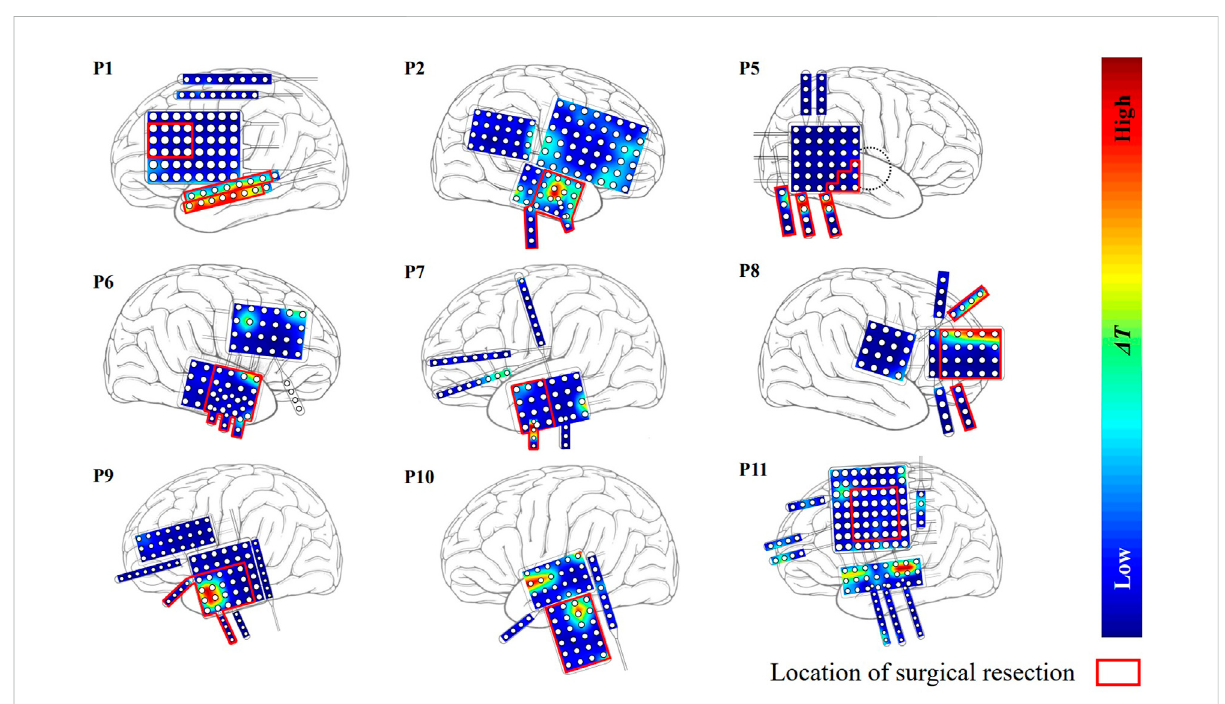
FIGURE 4 The distribution of Δ T for the other nine patients except P3 and P4. Red region indicates that the effect of modulation is strong.